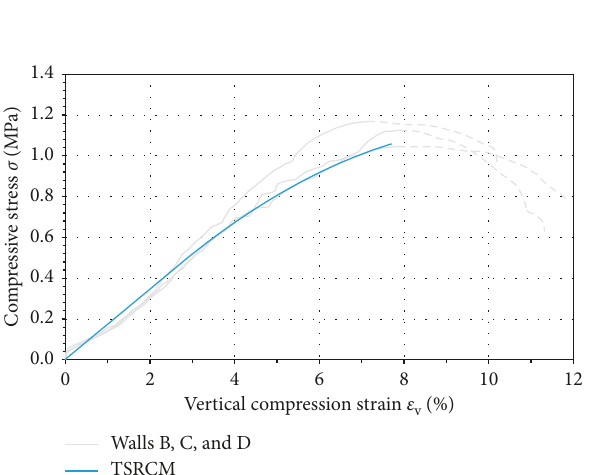
Figure 13: Comparison between TSRCM and experimental results in terms of stress-strain diagrams.